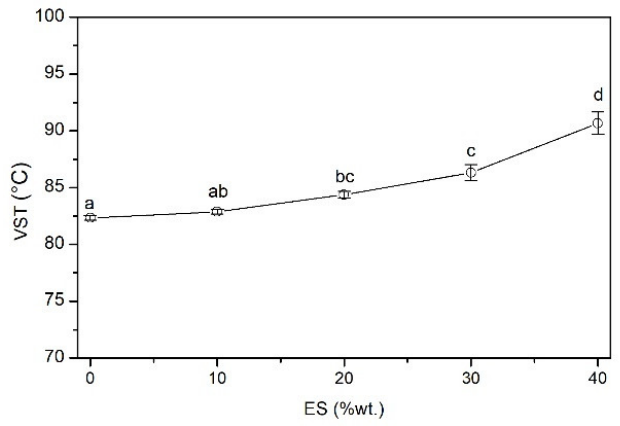
Figure 7. Vicat softening temperature (VST) vs. ES content.